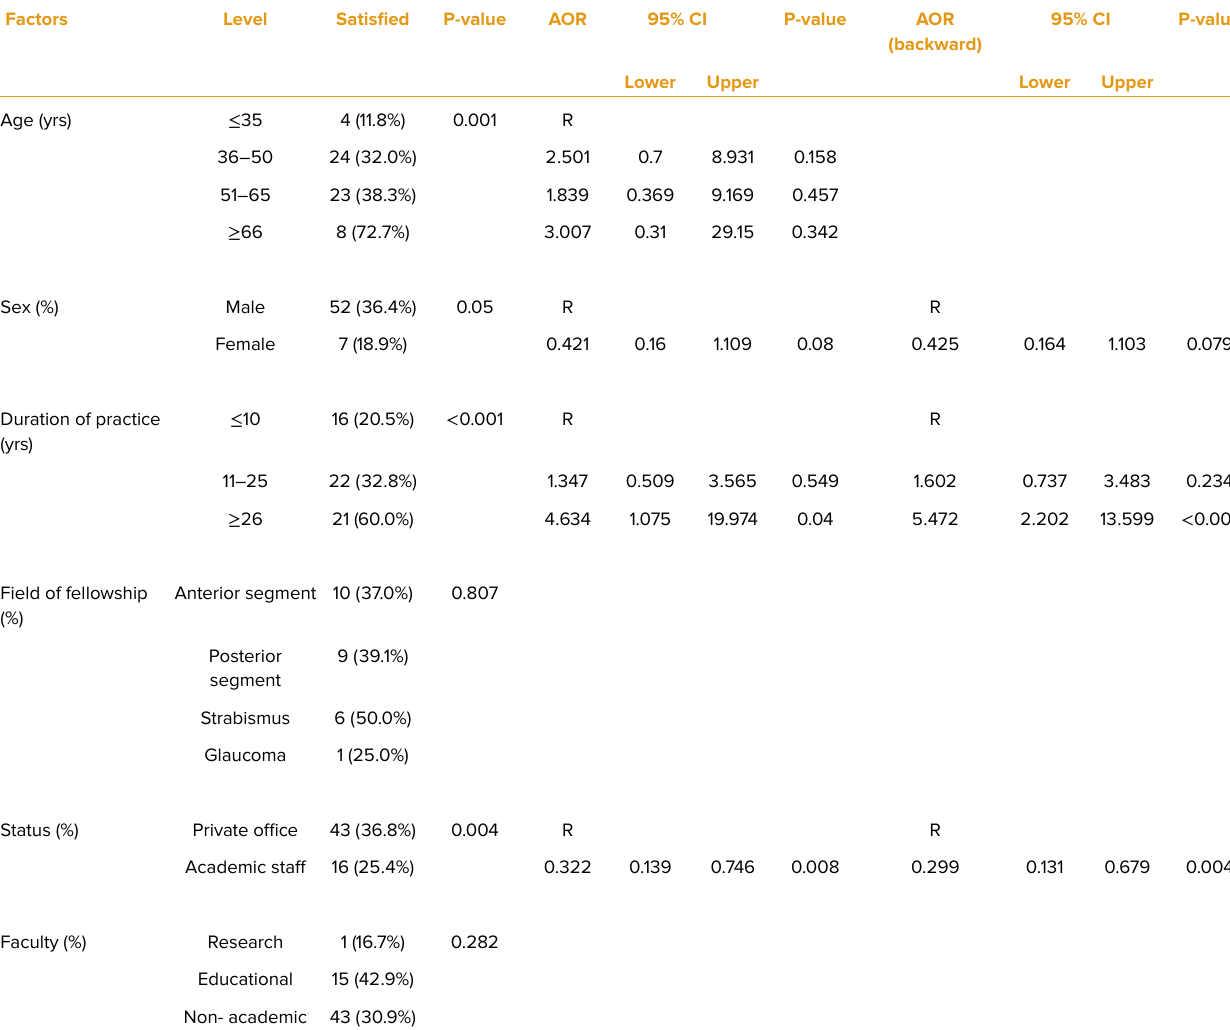
Table 3. Job satisfaction of participants based on their characteristics.